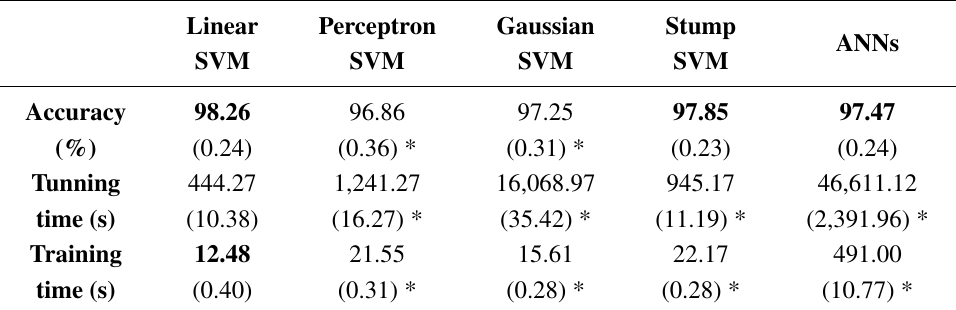
Table 6. Summary results of SVMs vs .